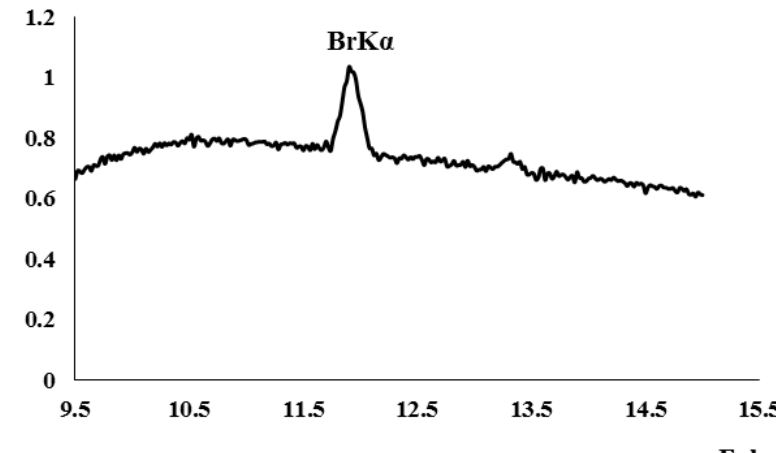
Figure 2. X-ray fluorescence spectrum Sil–Im.